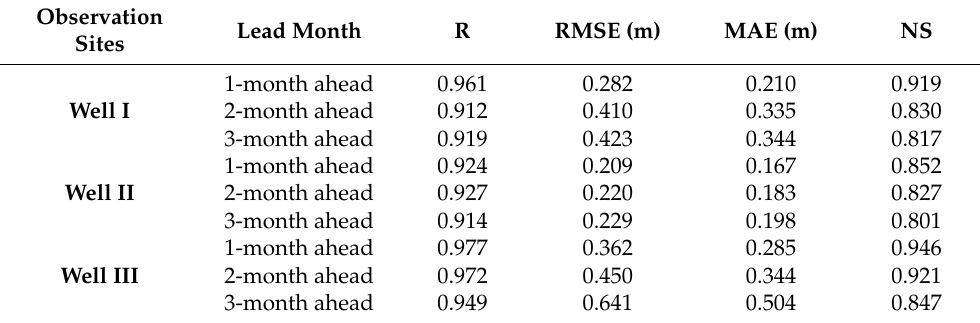
Table 4. Performance analysis of the VELM models during testing periods for three sites.